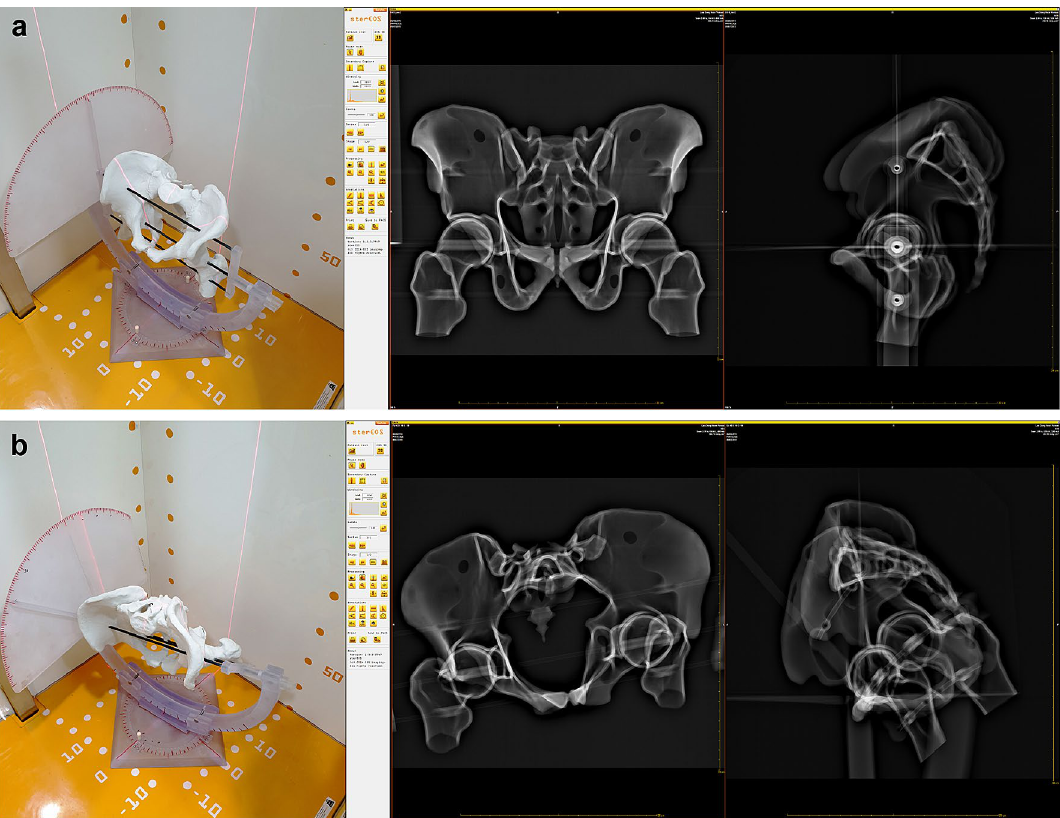
Figure 6. Image acquisition of the pelvic phantom performed for 105 position variations. SterEOS software (version 1.5.3.7947, EOS Imaging, Paris, France) was used to create the image. ( a ) The biplanar images depict the neutrally positioned phantom in the EOS system. ( b ) The biplanar images reveal the phantom with + 10° rotation and − 10° obliquity, and 45°